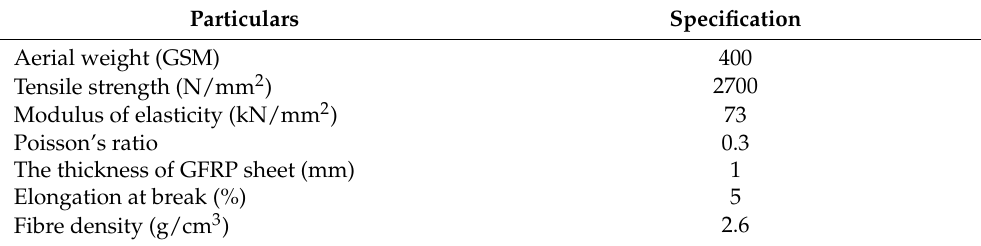
Table 3. Specification of the GFRP